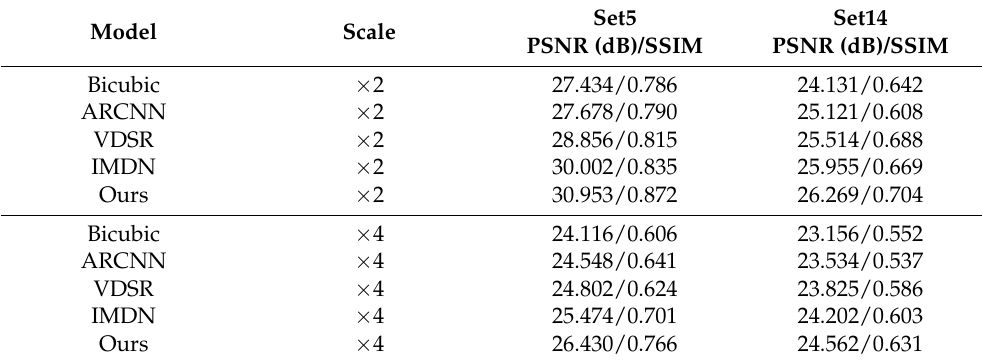
Table 1. The comparative results on PSNR and SSIM.